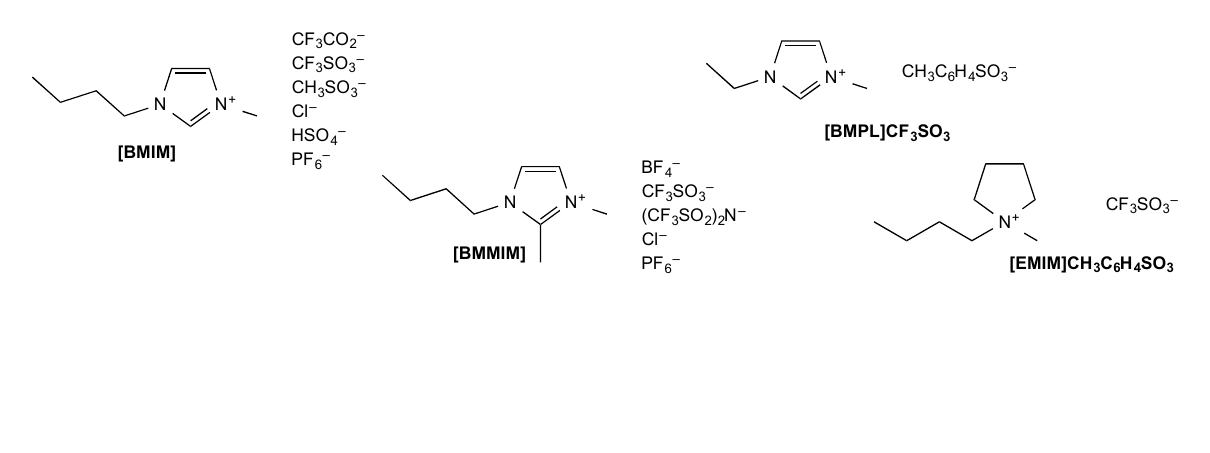
Figure 11. The structures and abbreviations of ILs used in this